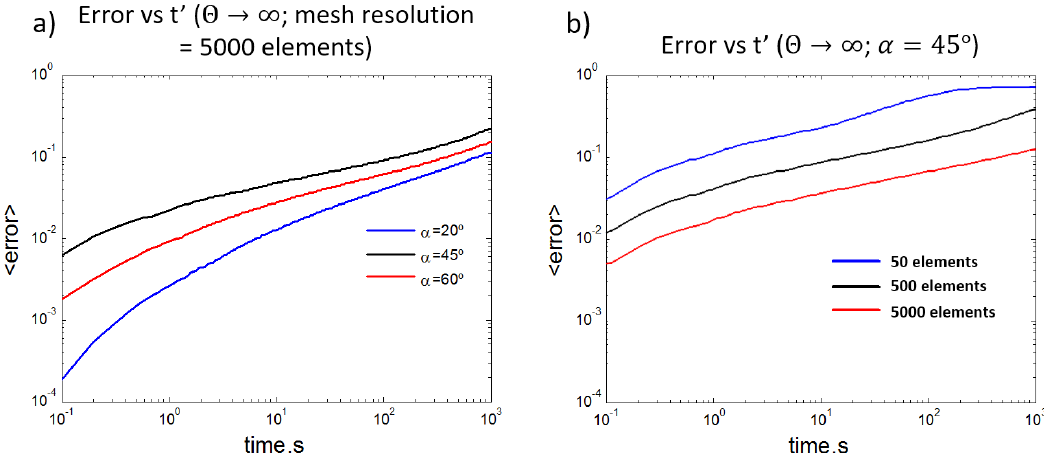
Figure 6. ( a ) Error, computed as defined in Equation (9) vs. time for an infinite diffusion ratio and various inclinations of the magnetic field for a mesh resolution of 5000 elements; ( b ) Error vs. time for a diffusion ratio equal to infinite for various mesh resolutions; the inclination is fixed at 45 degrees.